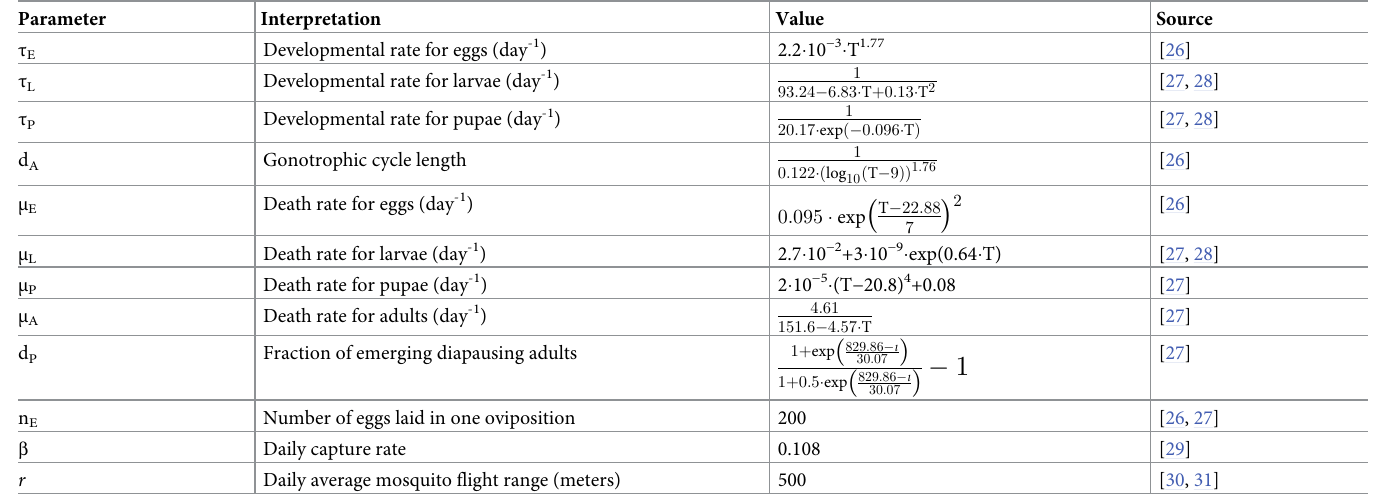
Table 1. Parameters for the entomological model.